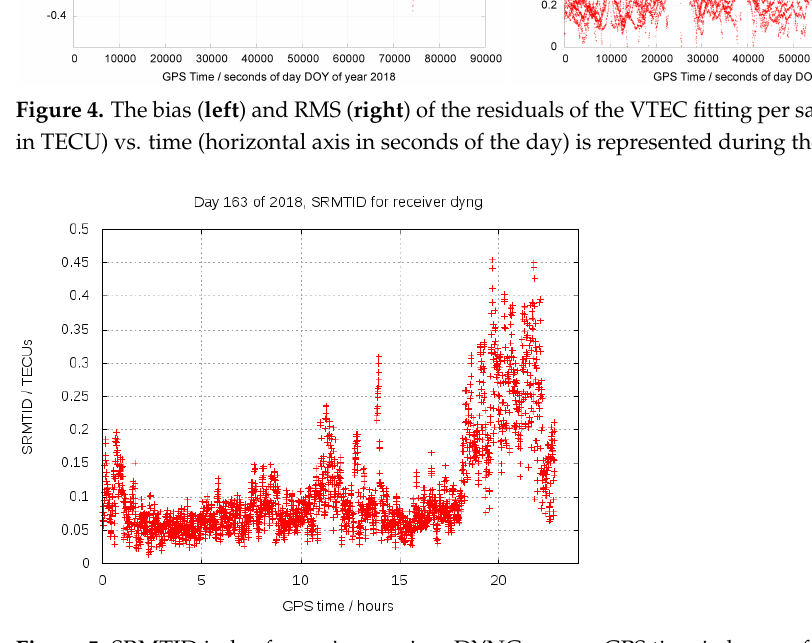
Figure 5. SRMTID index for roving receiver DYNG, versus GPS time in hours of day 12 June